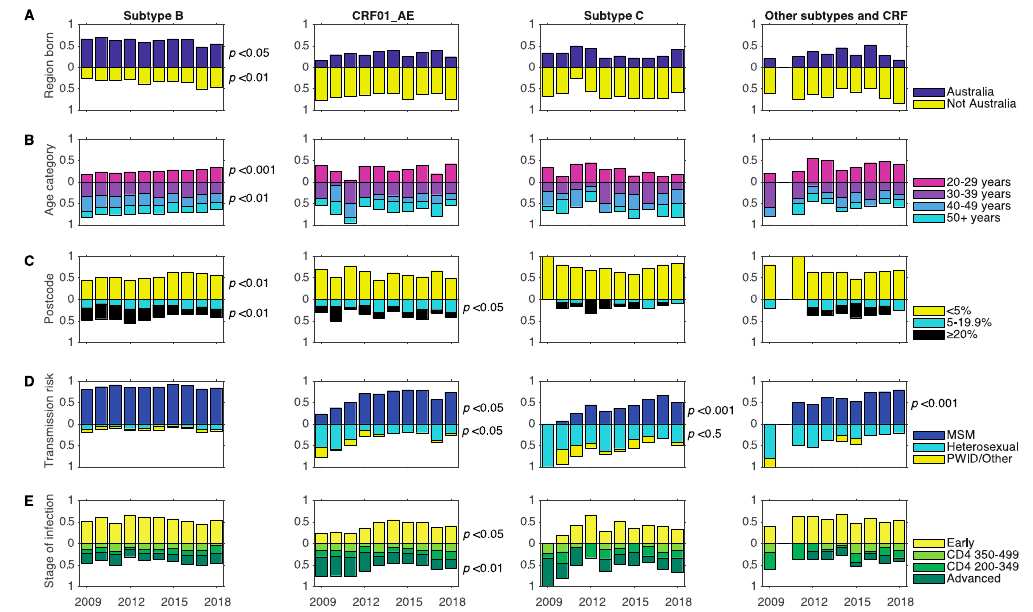
Figure 2. Time-specific changes in demographics. Proportion of sequences from infections among individuals with di ff erent demographics are shown for the time span of 2009–2018 for subtype B, C, CRF01_AE, and other subtype and CRFs. p values showing significant changes over time are shown next to the panel. ( A ) region born: Australia (blue), not-Australia (yellow); changes over time were significant for subtype B. ( B ) Age category: 20–29 years old (pink), 30–39 years old (purple), 40–49 years old (blue), 50 + years (cyan); changes were significant for subtype B 20–29 years old and 40–49 years old). ( C ) Postcode category according to proportion of gay male population: < 5% (yellow), 5–19.9% (cyan), ≥ 20% (black); changes were significant for CRF01_AE 5–19.9%. ( D ) Transmission risk